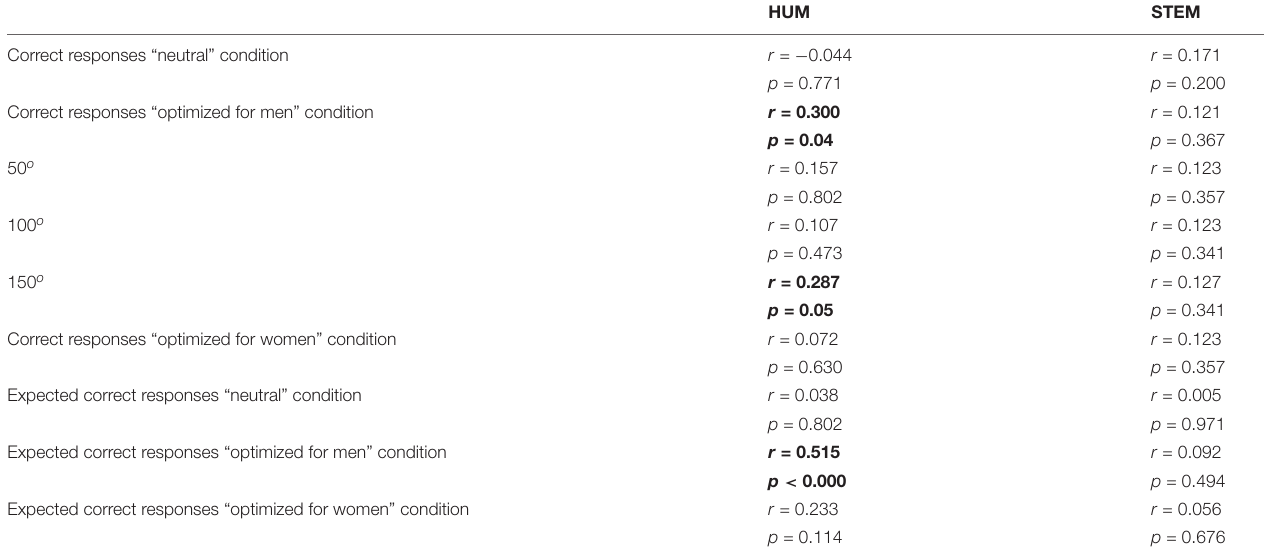
TABLE 3 | Correlations between the IAT “influence” scores and 3DMRT performance in HUM and STEM